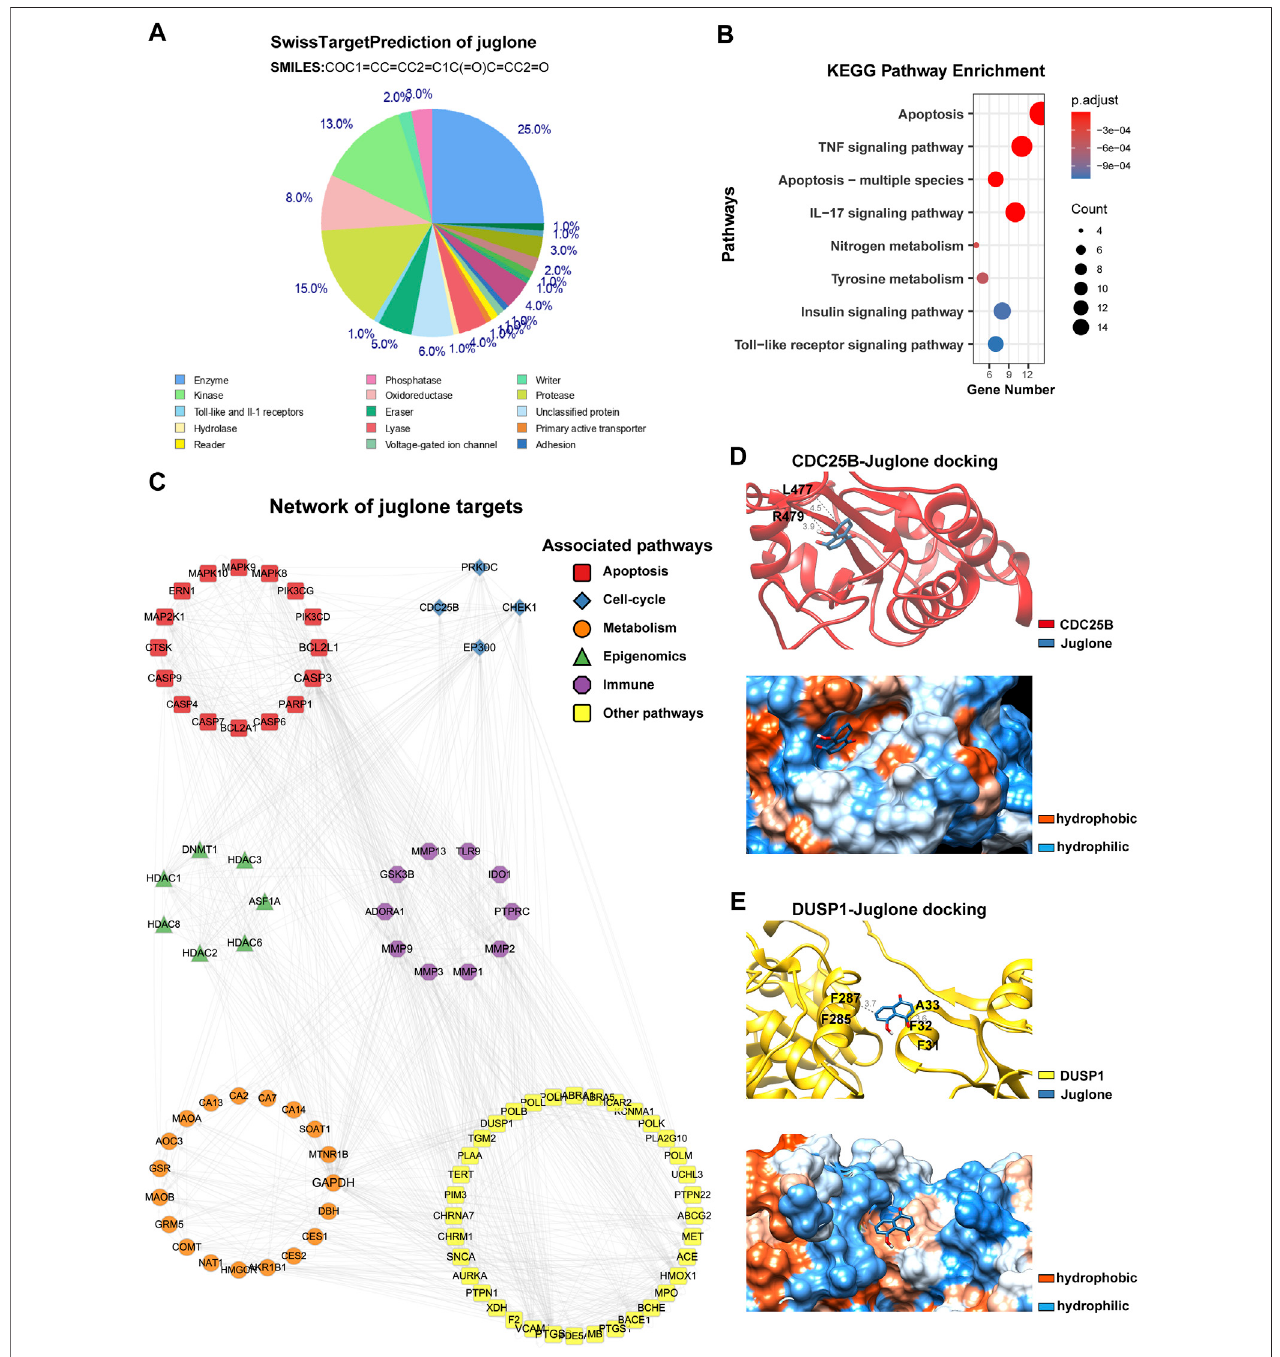
FIGURE 4 | Juglone had a broad spectrum of potential targets. (A) The predicted targets of juglone via SwissTargetPrediction. (B) KEGG pathway enrichment analysis of the predicted targets of juglone. (C) Topological network of juglone targets. Colors of genes are coded for different pathways (apoptosis, cell-cycle, metabolism,epigenomics,immune,andotherpathways). (D) Molecular dockingofjuglonewithCDC25B.Theblueand redribbonsrepresent thejugloneandCDC25B, respectively. The blue and orange dots represent the hydrophilic and hydrophobic amino acids, respectively. (E) Molecular docking of juglone with CDC25B. The blue and yellow ribbons represent the jugloneand DUSP1, respectively. The blue and orange dotsrepresentthehydrophilic and hydrophobicamino acids, respectively.